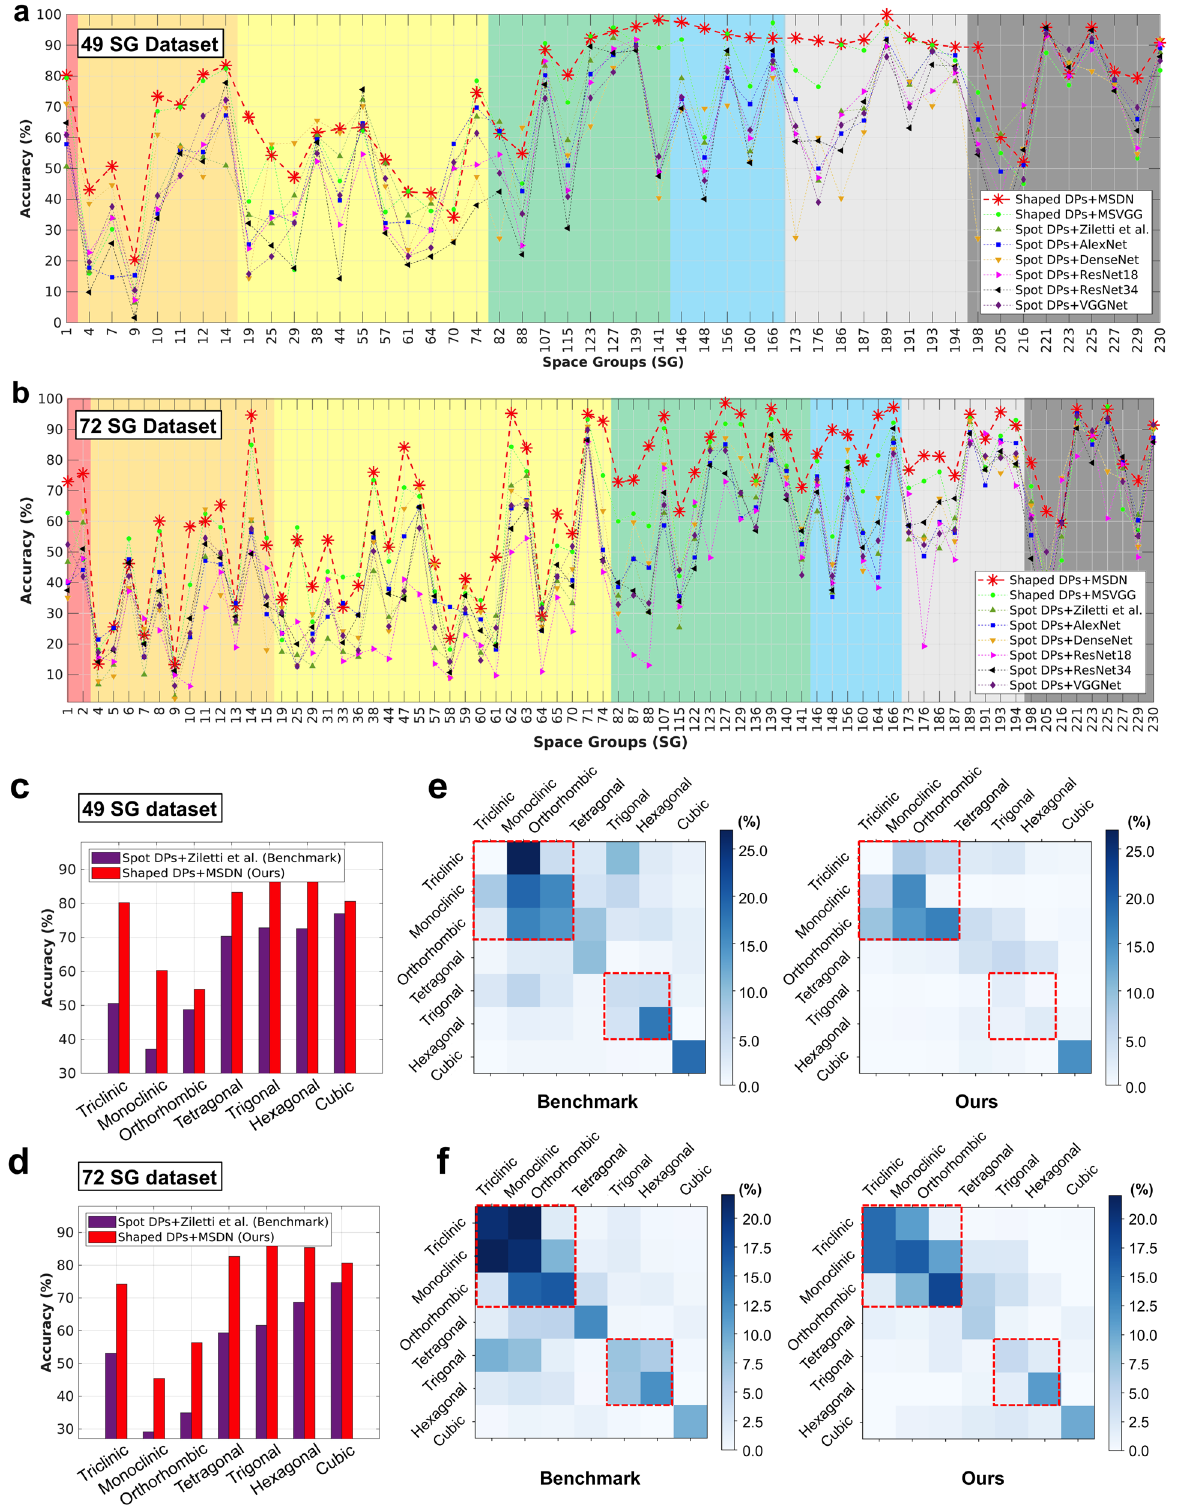
Fig. 6 Decomposition analysis to identify the origins of performance improvement. a , b Classi fi cation results for individual space groups from the 49 SG ( a ) and 72 SG ( b ) datasets. The background colors represent the seven types of crystal systems, as in Fig. 2a. c , d Average classi fi cation accuracy by crystal system type for the 49 SG ( c ) and 72 SG ( d ) datasets. e , f Matrices showing the distribution rates (%) of incorrect predictions for the 49 SG ( e ) and 72 SG ( f ) datasets. If the rate is, for example, 20% for the [monoclinic, orthorhombic] coordinate in a matrix, this means that 20% of the materials belonging to monoclinic systems in our dataset are incorrectly classi fi ed as belonging to SGs corresponding to orthorhombic systems. Red dotted boxes highlight the regions that are considerably different between the benchmark and our